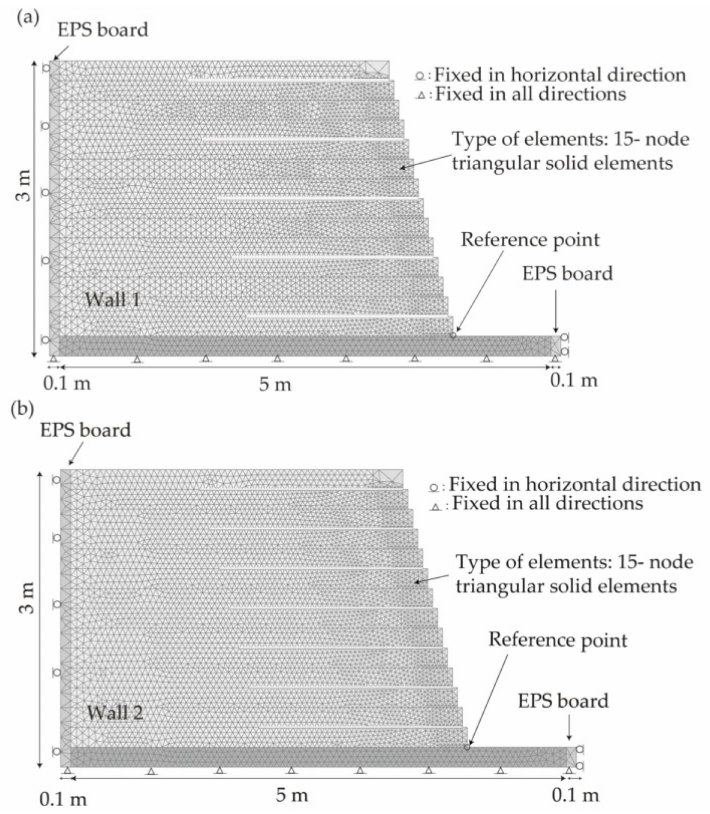
Figure 7. The mesh and boundary conditions: ( a ) wall 1; ( b ) wall